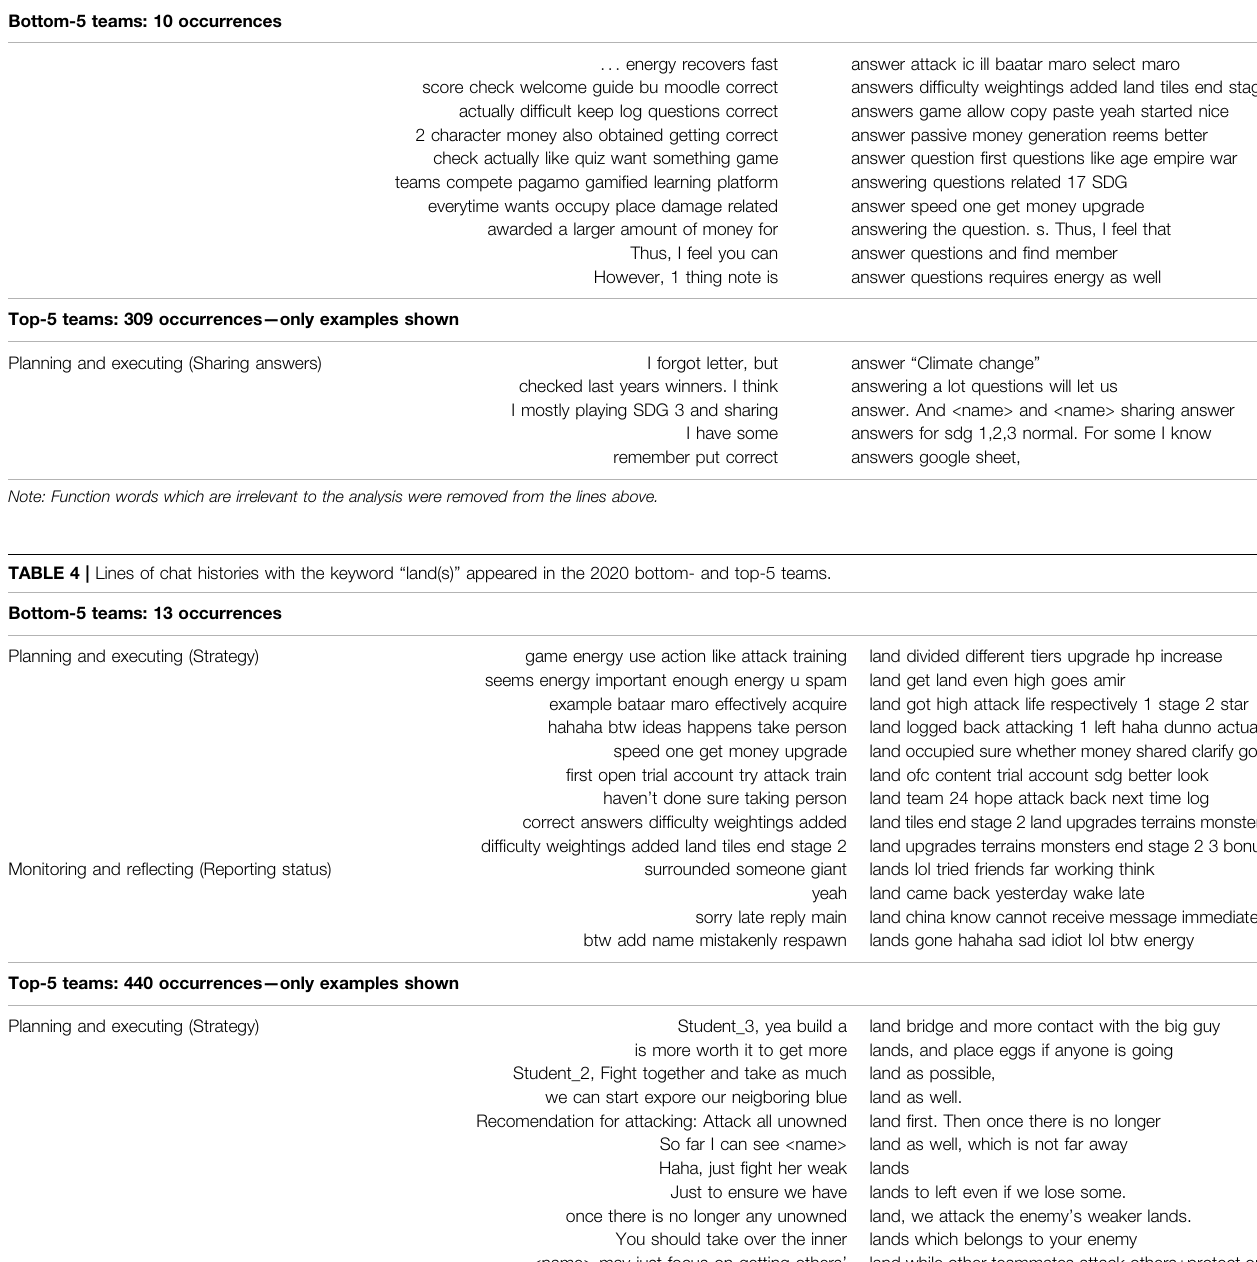
TABLE 3 | Lines of chat histories with the keyword “ answer ” appeared in the 2020 bottom- and top-5 teams. Bottom-5 teams: 10 occurrences